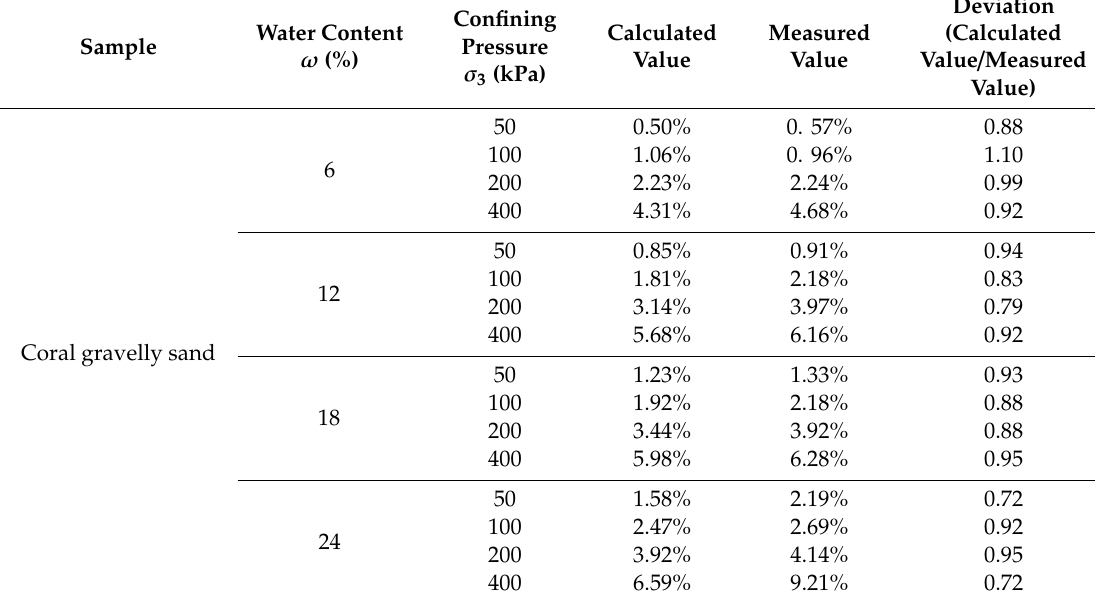
Table 7. Comparison between the calculated value and measured value of Br